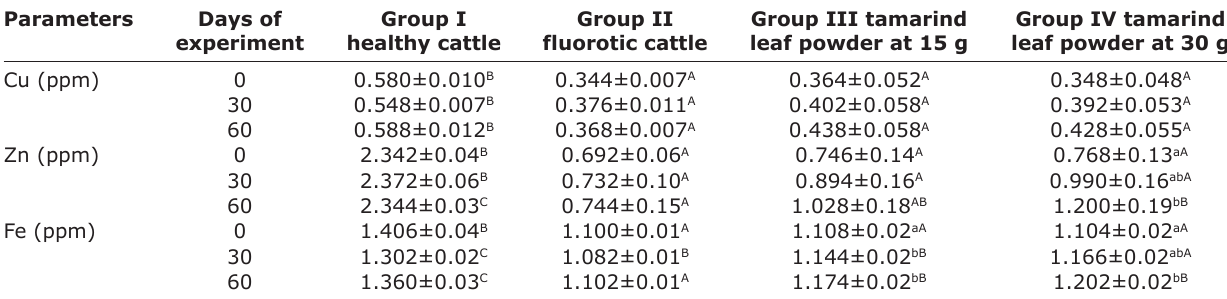
Table-1: Trace mineral status (ppm) in cattle from fluorotic area along with normal cattle.